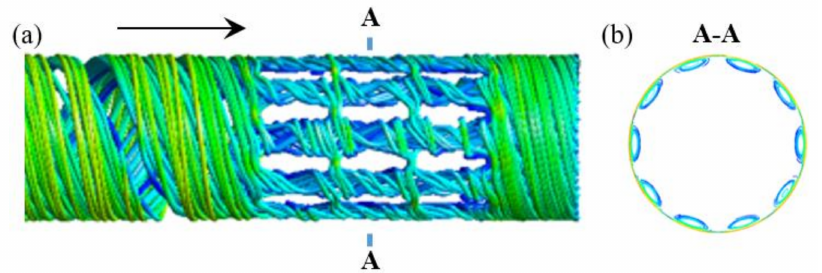
Figure 6. Streamline distributions of the axial direction ( a ) and the vertical cross-section ( b ) in the screw channel for case 6.